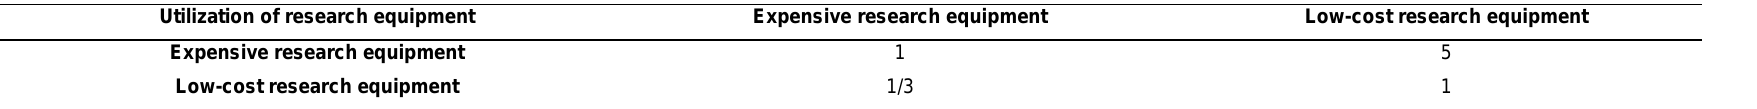
Table 8. Importance evaluation of utilization of research equipment